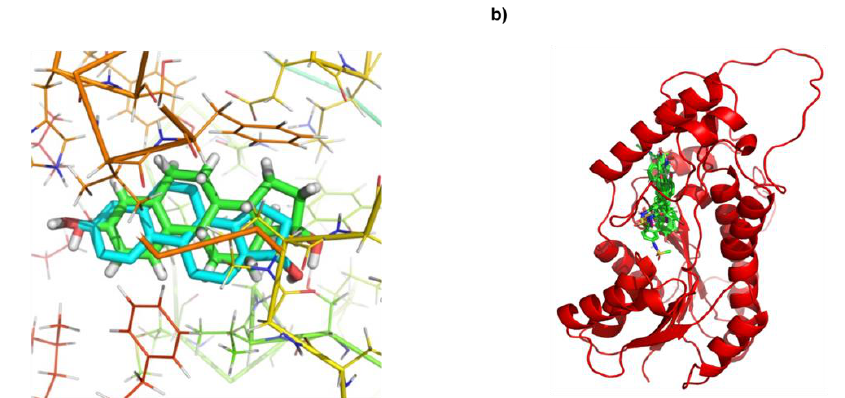
Figure 5. Validation of docking strategy using re-docking approach and binding mode of halogen- substituted compounds. ( a ) Root-mean-square deviation (RMSD) of 1.03 Å between the original complex and our redocked complex using native ligand Estradiol. ( b ) The binding conformation of halogen-substituted ligands with 17β -HSD1 receptor.